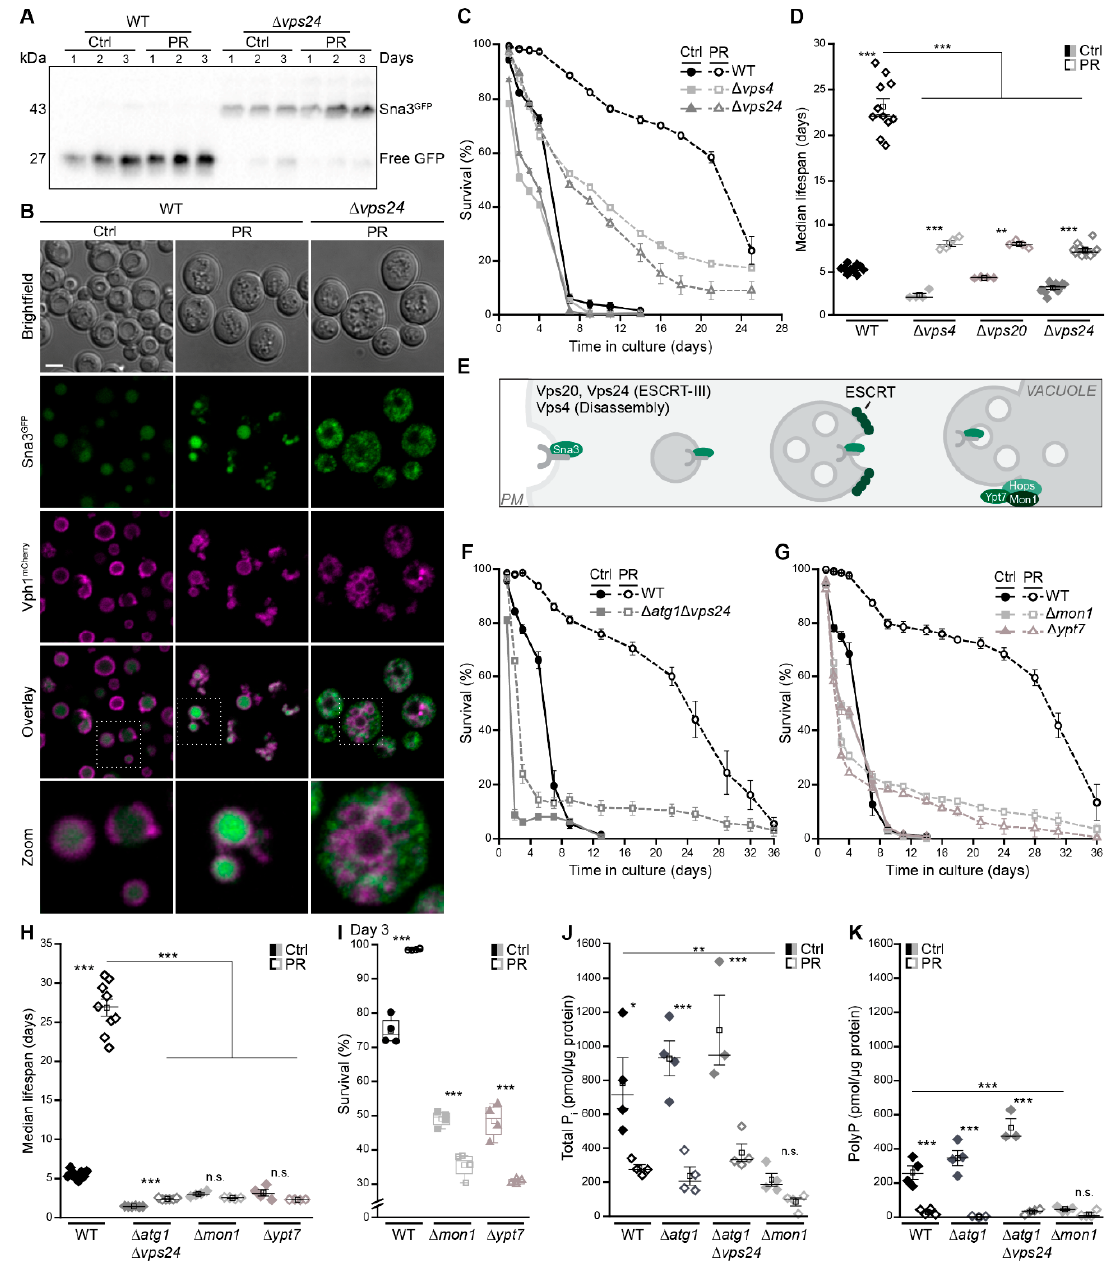
Figure 5. Autophagy and the multivesicular body pathway work in parallel to sustain survival upon phosphate exhaustion. ( A ) Immunoblot of WT and ∆ vps24 cells harboring endogenously GFP-tagged Sna3 grown in standard (Ctrl) or phosphate-restriction (PR) media. Blots were probed with an antibody against GFP to assess GFP liberation. ( B ) Confocal microscopy of WT and ∆ vps4 cells harboring endogenously GFP-tagged Sna3 and mCherry-tagged Vph1. Images of ∆ vps4 cells were post-processed differently to visualize Sna3 GFP . Scale bar represents 3 μ m. ( C ) Survival during chronological aging, determined via flow cytometric quantification of PI staining, of WT, ∆ vps4 and ∆ vps24 cells grown on Ctrl or PR media; n = 4. ( D ) Median lifespan of WT, ∆ vps4, ∆ vps20 and ∆ vps24 cells. ( E ) Schematic showing the multivesicular body (MVB) pathway and key players of vacuole fusion. ( F–H ) Survival during chronological aging of WT and ∆ atg1 ∆ vps4 cells ( F ) and of WT, ∆ mon1 and ∆ ypt7 cells ( G ) grown on Ctrl or PR media, as well as corresponding median lifespan (H); n > 4. ( I ) Survival of WT, ∆ mon1 and ∆ ypt7 cells on day 3 of the aging shown in ( G ). ( J , K ) Total phosphate ( J ) and polyphosphate (K) levels in WT, ∆ atg1 , ∆ atg1 ∆ vps4 and ∆ mon1 cells grown for 24 h on Ctrl or PR media; n = 4, except ∆ atg1 ∆ vps4 n = 3. For statistical analysis, Welch-ANOVA with Dunnett T3 post hoc test ( D , H ) and one-Way ANOVA with Tukey post hoc test ( I – K ) was used. * p < 0.05, ** p < 0.01 and *** p < 0.001; ns not significant.